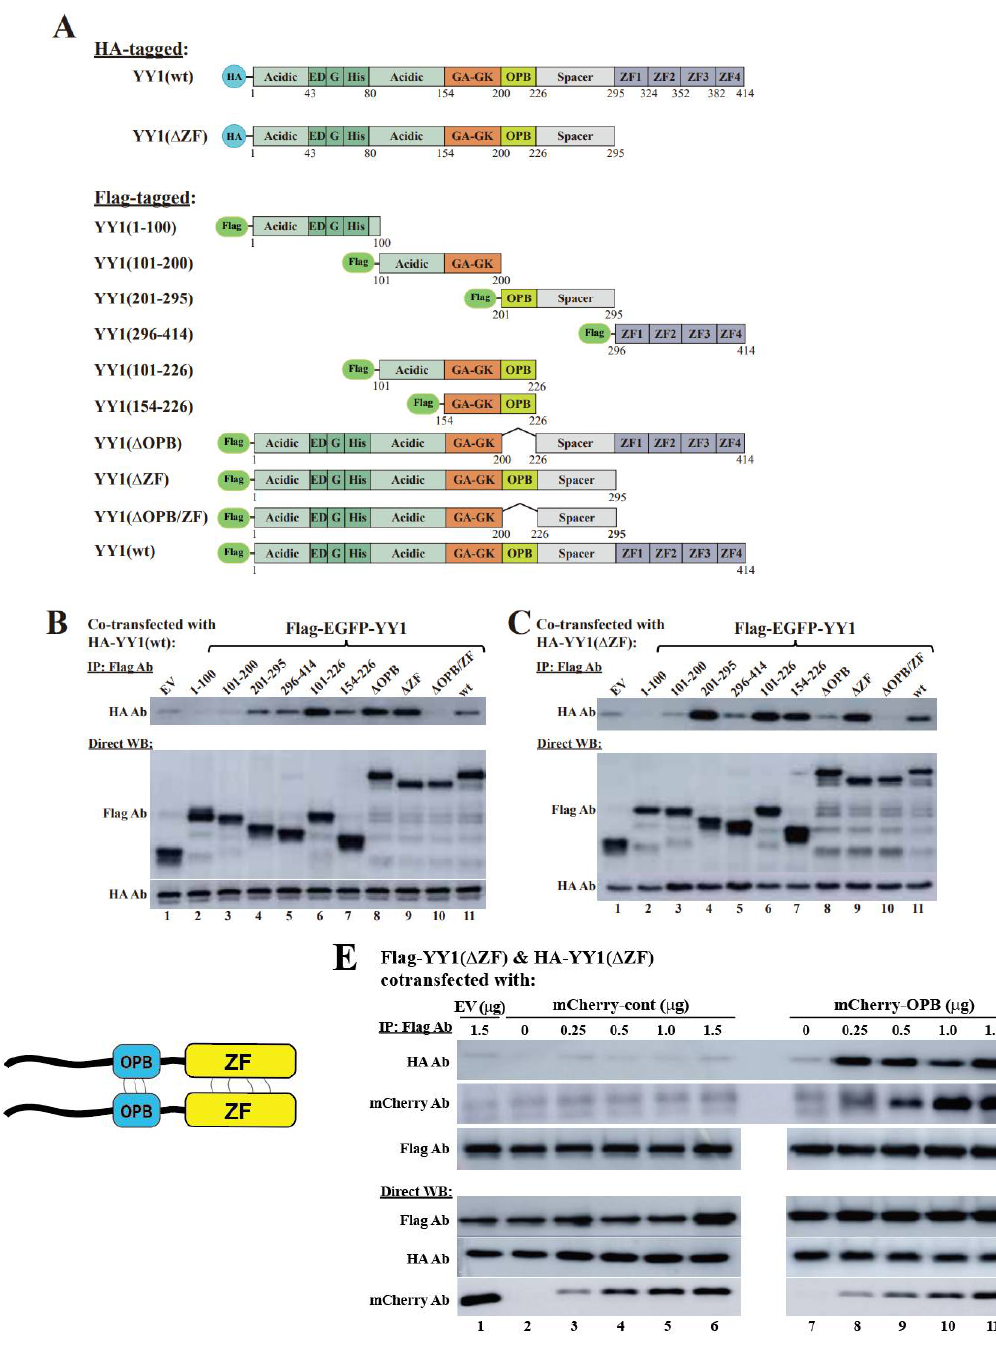
Figure 2. Identification of the binding sites responsible for YY1 dimerization by co-immunoprecipitation (co-IP). ( A ) Diagrams of HA- and Flag-tagged YY1 wt and its mutant proteins used for co-IP studies. ( B , C ) Co-IP studies to determine the binding sites responsible for YY1 dimerization. HA-YY1 wt ( B ) or its ΔZF mutant ( C ) expression plasmid was individually cotransfected with Flag-EGFP-YY1 wt and mutant expression vectors, as well as an empty vector (EV). Cell lysates were co-IPed by a Flag antibody, and HA and Flag antibodies were used in Western blot analyses. ( D ) Schematic diagram of a predicted YY1 dimerization mode. ( E ) Effects of the OPB on intermolecular interaction of YY1. Different amounts of mCherry-cont, mCherry-OPB and mCherry plasmids were individually cotransfected with Flag-EGFP-YY1(ΔZF) and HA-YY1(ΔZF) expression vectors, followed by co-IP of the Flag antibody. HA, mCherry and Flag antibodies were used in Western blot analyses.